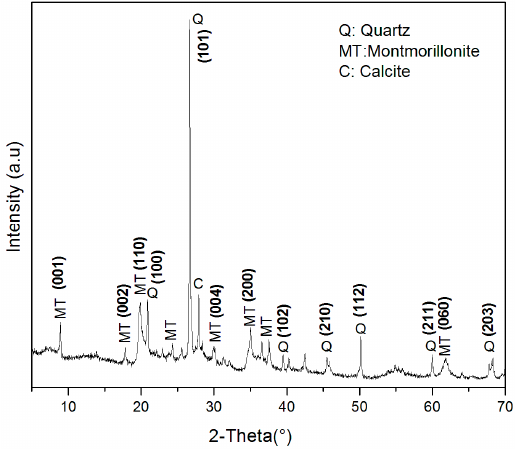
Figure 1. X-ray diffraction analysis (XRD) pattern of Montmorillonite-KSF (MT-KSF) clay.